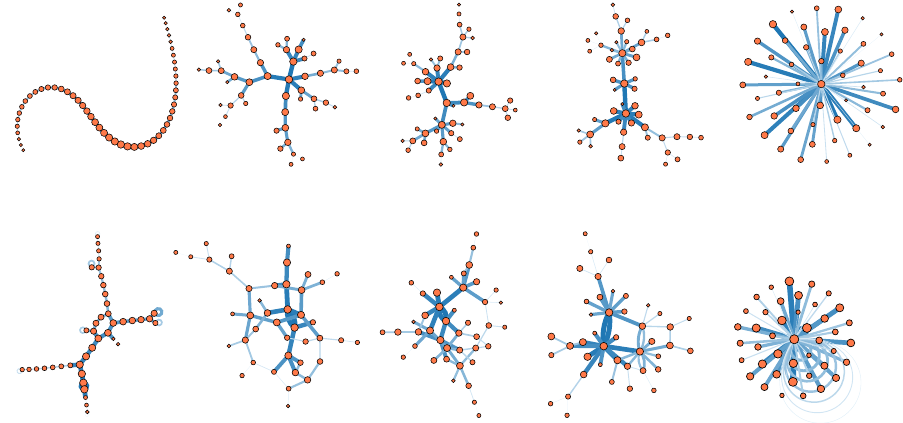
FIG. 2. Network zoo. Examples of networks generated by the process with b ¼ 1 (top row) and b ¼ 0 . 75 (bottom row), and γ ∈ f − 10 ; − 1 ; 0 ; 1 ; 10 g (from left to right). The width and color of edges encode this history; older edges are drawn with thick, dark strokes, while younger edges are drawn using thin, light strokes. The age of the nodes is encoded in their radius.